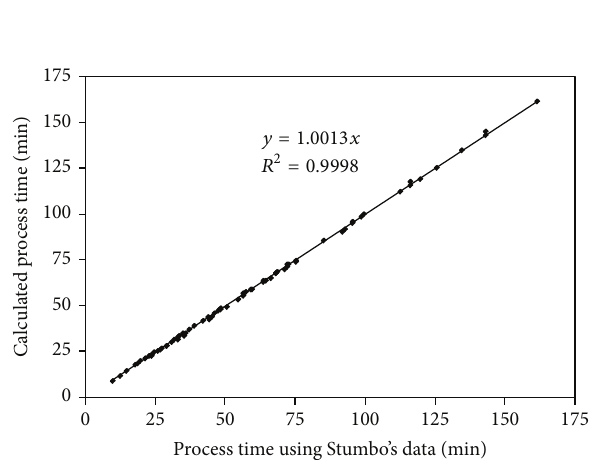
Figure 5: Comparison of the process time, calculated using 𝑔 values from Stumbo’s tables [7], and the mathematical model of this